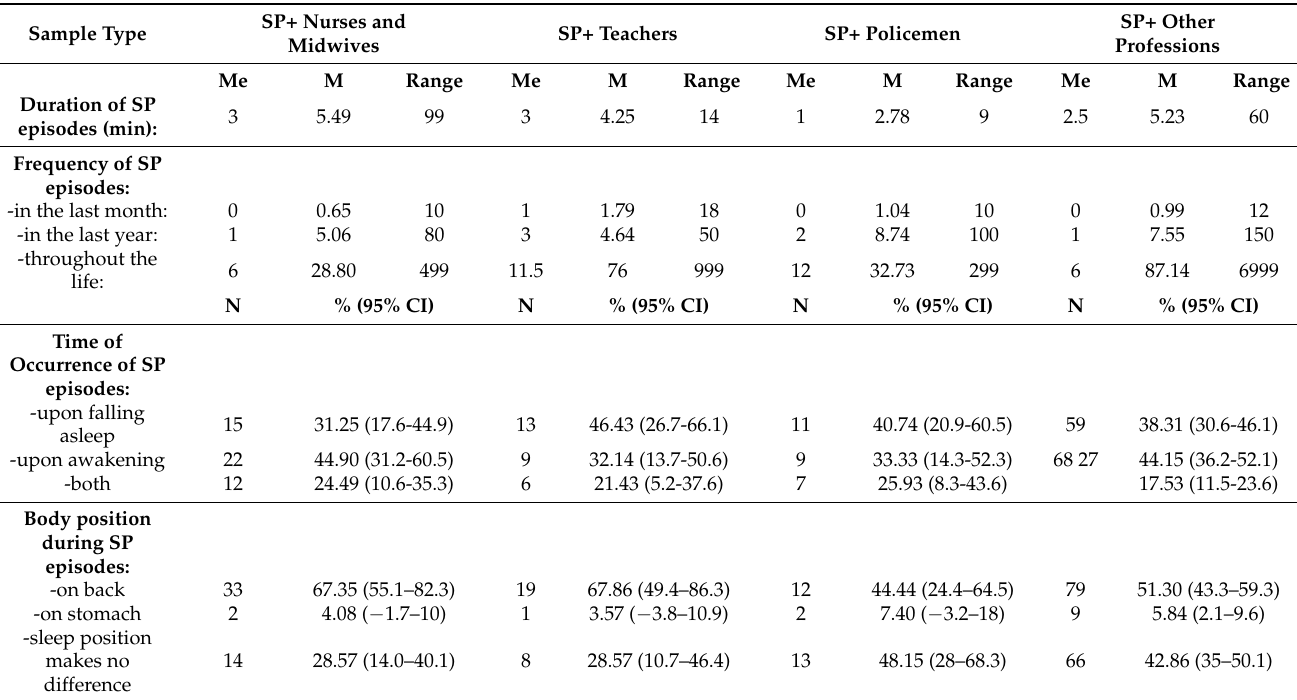
Table 5. Characteristics of SP episodes in the studied SP+ profession